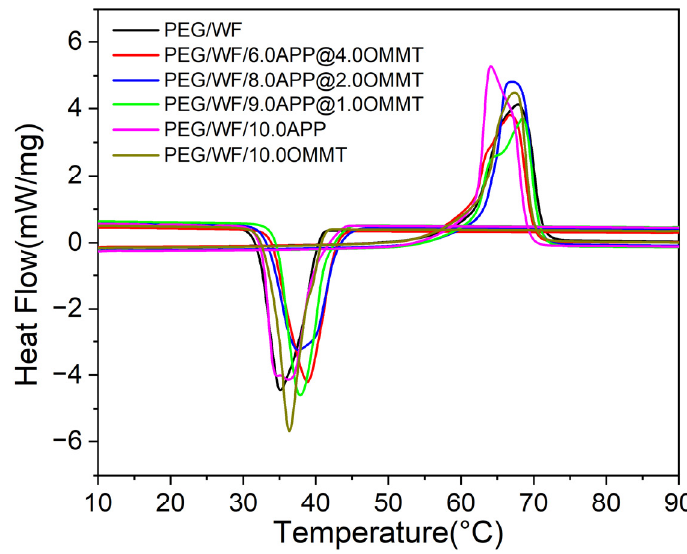
Figure 5. DSC curves of PEG/WF and its composites. Table 2. Latent heat storage properties of PEG/WF and its composites. Sample No.